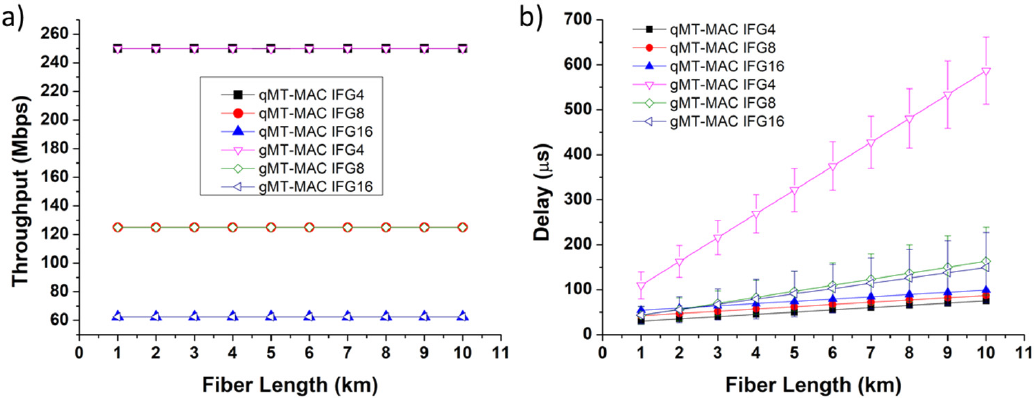
Figure 6. ( a ) Throughput vs. fiber length for three combined CEXP flows with IFG 4, 8, and 16, respectively, ( b ) Delay vs. fiber length for three combined CEXP flows with IFG 4, 8, and 16, respec- tively.